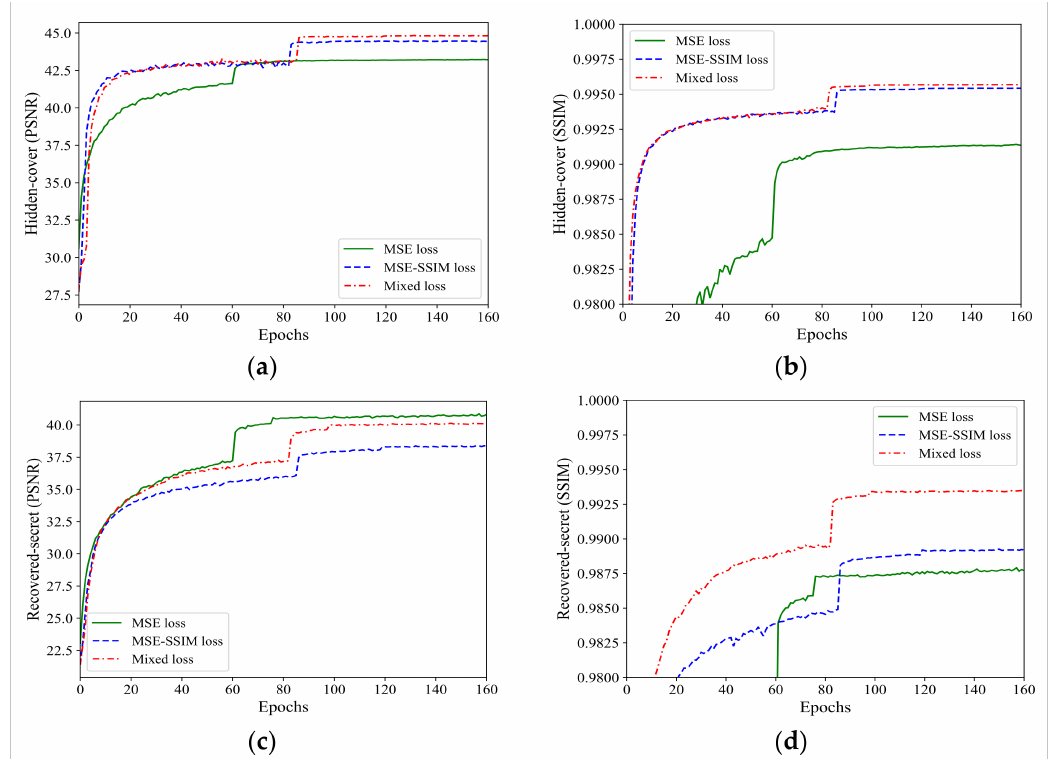
Figure 4. Influence of different loss functions. ( a ) PSNR values of the hidden images, ( b ) SSIM values of the hidden images, ( c ) PSNR values of the recovered secret images, ( d ) SSIM values of the recovered secret